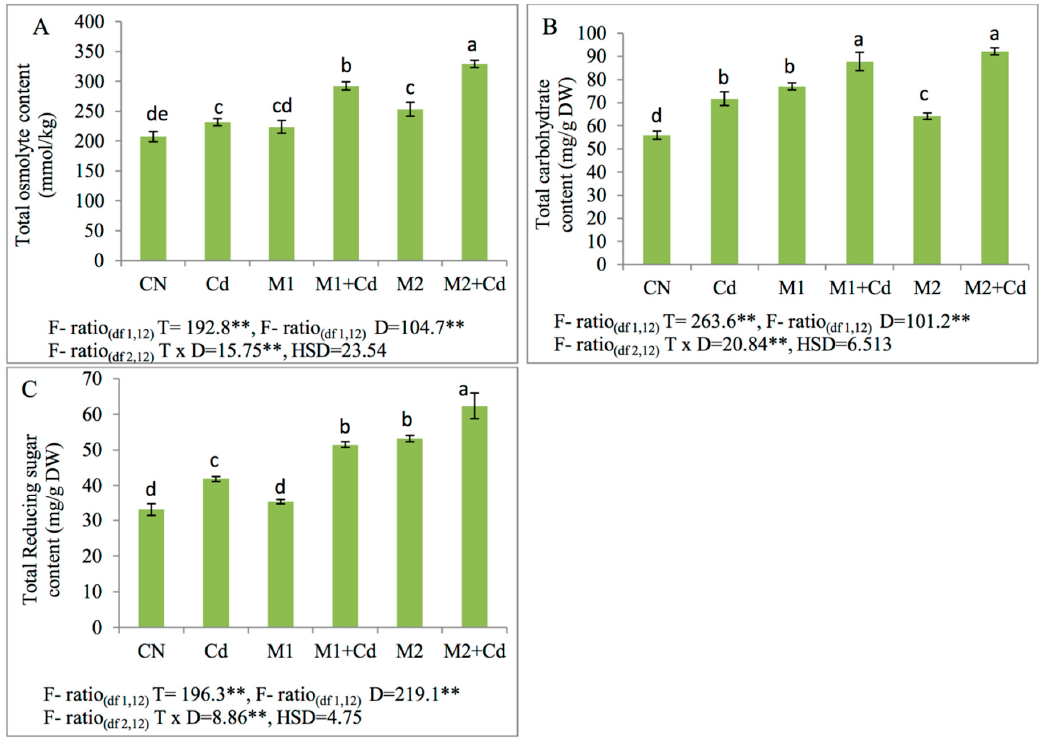
Figure 4. E ff ect of Cd (0.4 mM), M1 (10 9 cells / mL) and M2 (10 9 cells / mL) and their combinations on di ff erent Osmoprotectants ( A ) Total osmolytes, ( B ) total carbohydrates, and ( C ) total reducing sugars in 45-day-old L. esculentum under Cd metal stress. Data is presented as means of 3 replicates ± S.D (standard deviation) and HSD values. F ratio values, * indicates significance at p ≤ 0.05 and ** indicates significance at p ≤ 0.01). Di ff erent letters on the table indicate that mean values of treatments are significantly di ff erent at p < 0.5 according to Tukey’s multiple comparison test